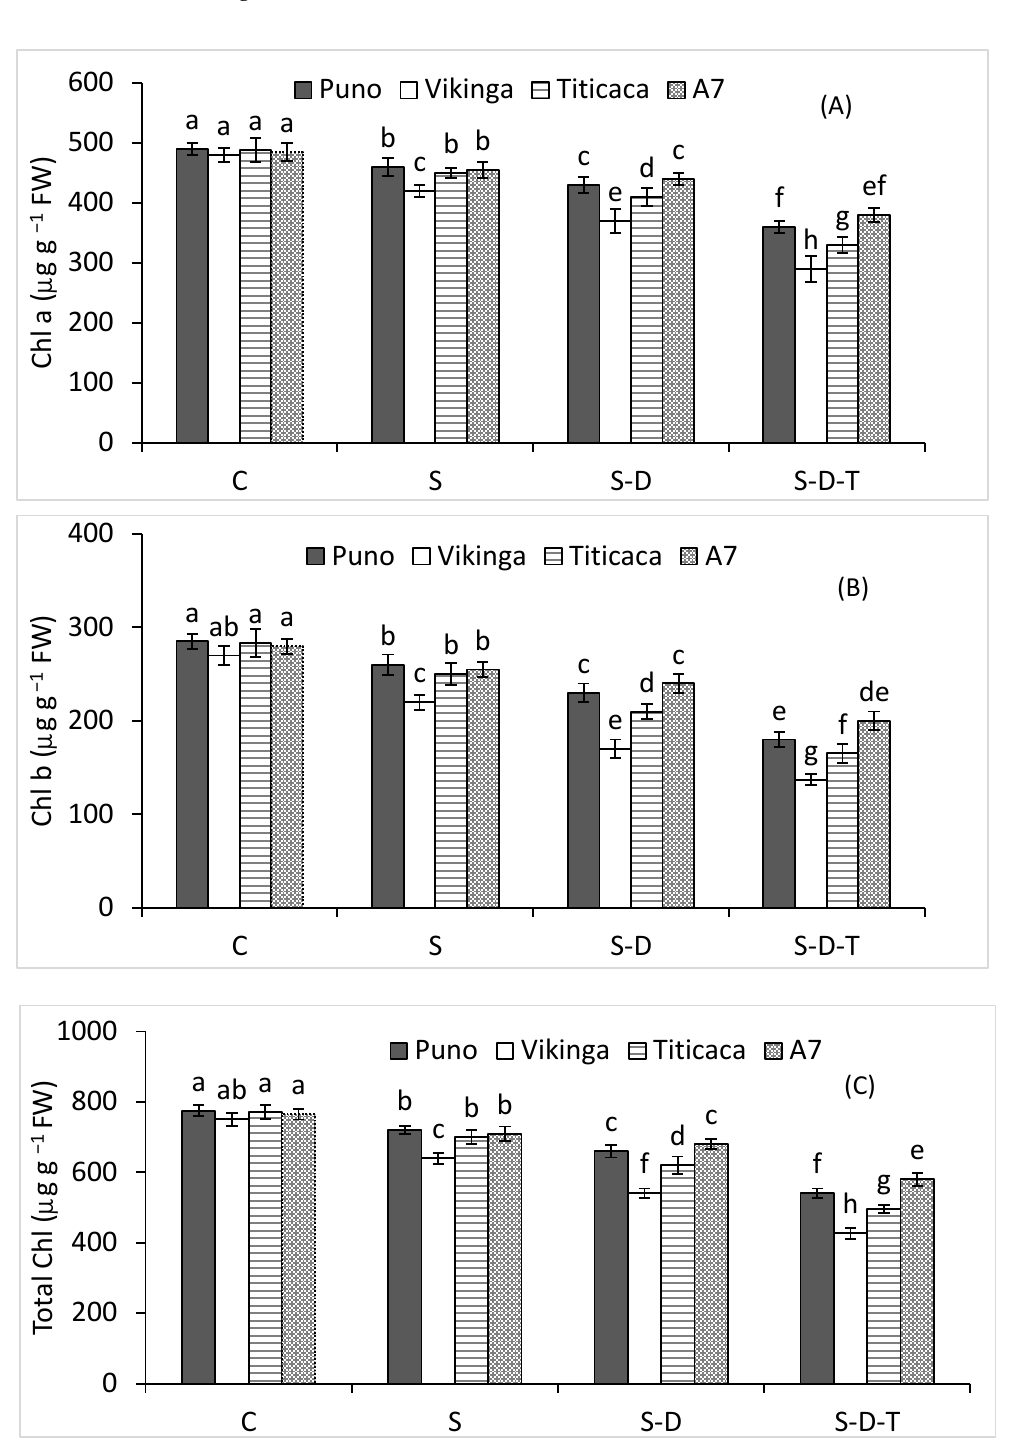
Figure 1. ( A ) Chlorophyll a, ( B ) chlorophyll b, and ( C ) total chlorophyll concentrations of quinoa genotypes under control (C), salinity (S), drought (D), and high-temperature (T) stress. S-D, combined salinity and drought treatment; S-D-T, combined salinity, drought, and high-temperature treatment. The values for each parameter are the means of three replicates ± SE. At the 5% probability level, bars with different letters indicate significant differences.